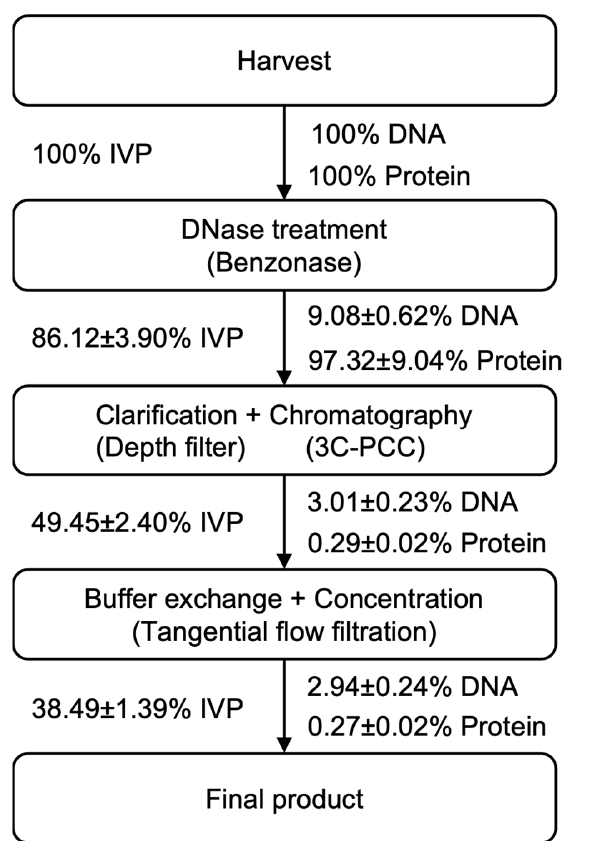
Figure 6. The schematic of the downstream process, infectious viral titer recovery, as well as for the DNA and protein removal.